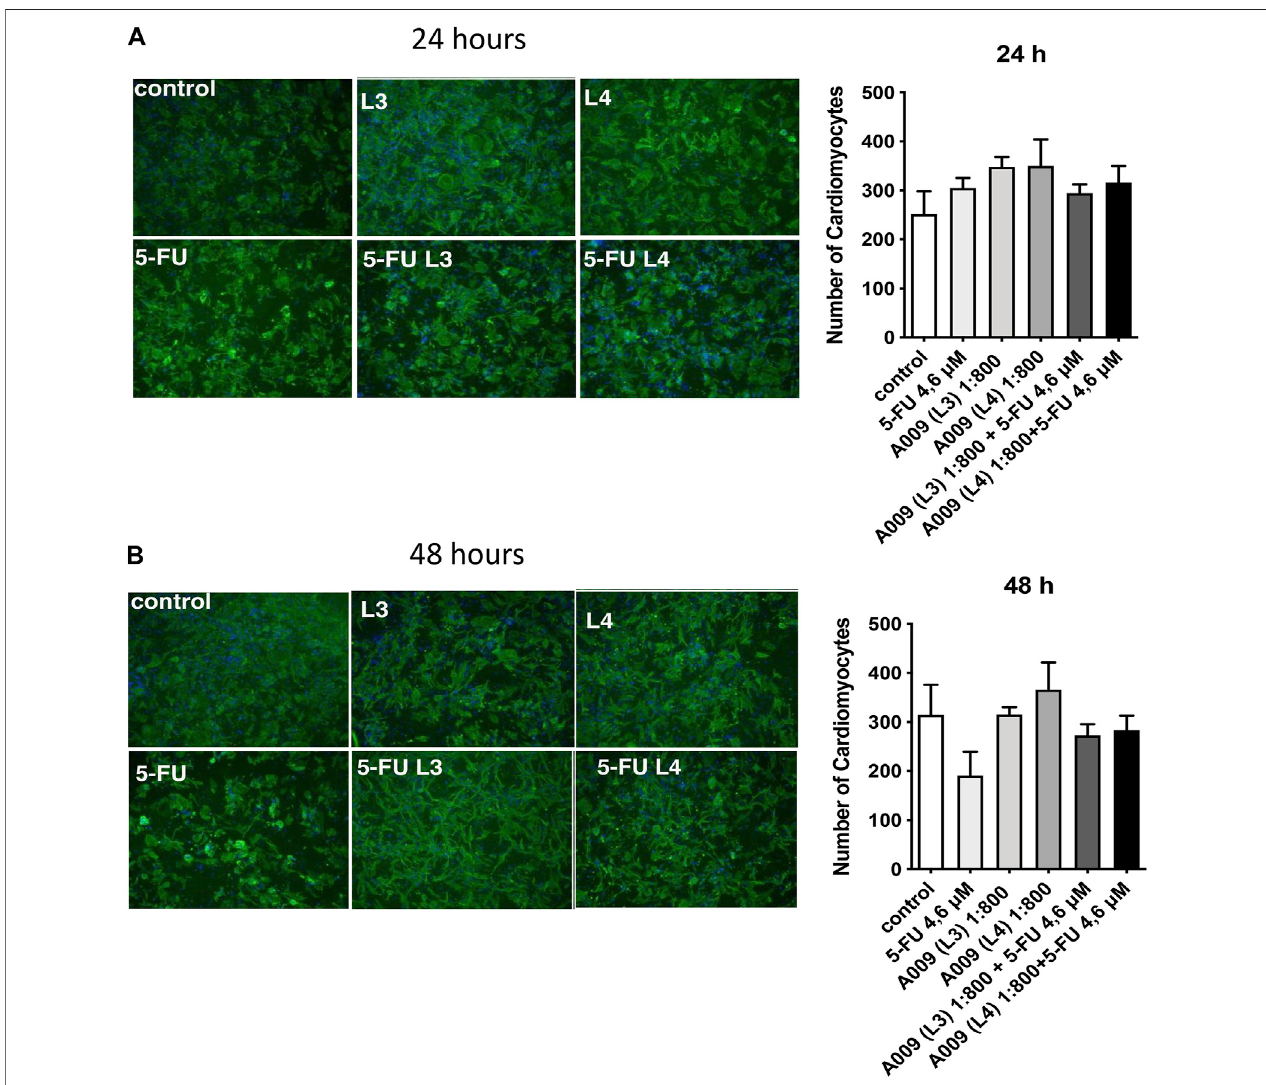
FIGURE 4 | Protective activities of A009 extracts on neonatal murine cardiomyocytes. The cardioprotective effects of the A009 extract on chemotherapy induced cardiotoxicities was assessed, in vitro , on neonatal murine cardiomyocytes. Neonatal murine cardiomyocytes were exposed for 24 h (A) and 48 h (B) to 5-FU (4.6 μ M) alone, A009 extracts (dilution 1:800, batches L3 or L4) alone, or the combination of the 5-FU and A009 extracts (dilution 1:800, batches L3 or L4). Number of cardiomyocyteswasnotaffectedby5FUafter 24 htreatments,whiletheOMWWextract improvedtheirnumbertoaslight butsigni fi cativepercent.After48 h5FU strongly decreased cardiomyocyte number to 60%. A009 alone did not lower the quantity of cardiomyocytes, and even slightly increased it as in the 24 h (in the L4 formulation). Addition to L3 and L4 together with the cytotoxic drug counteracted 5FU effect at 48 h. Data are showed as mean ± SEM. 5-FU: 5- fl uoro-Uracile; L3/L4: A009 batch extract; Control: vehicle control; 5- fl